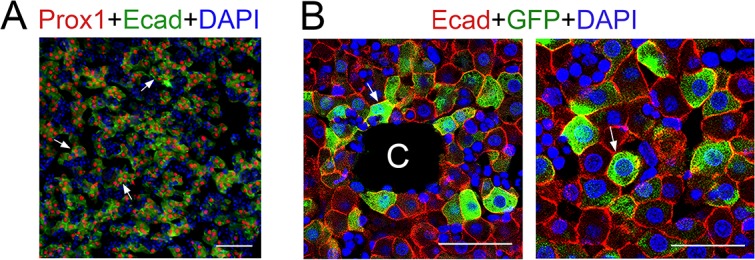
E-cadherin and claudin-2/GFP are expressed throughout the newborn liver.(A) All hepatocytes express Prox1 (red) and E-cadherin (green, arrows) in P2 wildtype livers. (B) All Claudin-2/GFP+ hepatocytes (arrows) located in perivenous (left) and parenchymal (right) areas express E-cadherin in P2 Cldn2-EGFP livers. C = central vein. Scale bars: 50 μm (A), 25 µm (B).